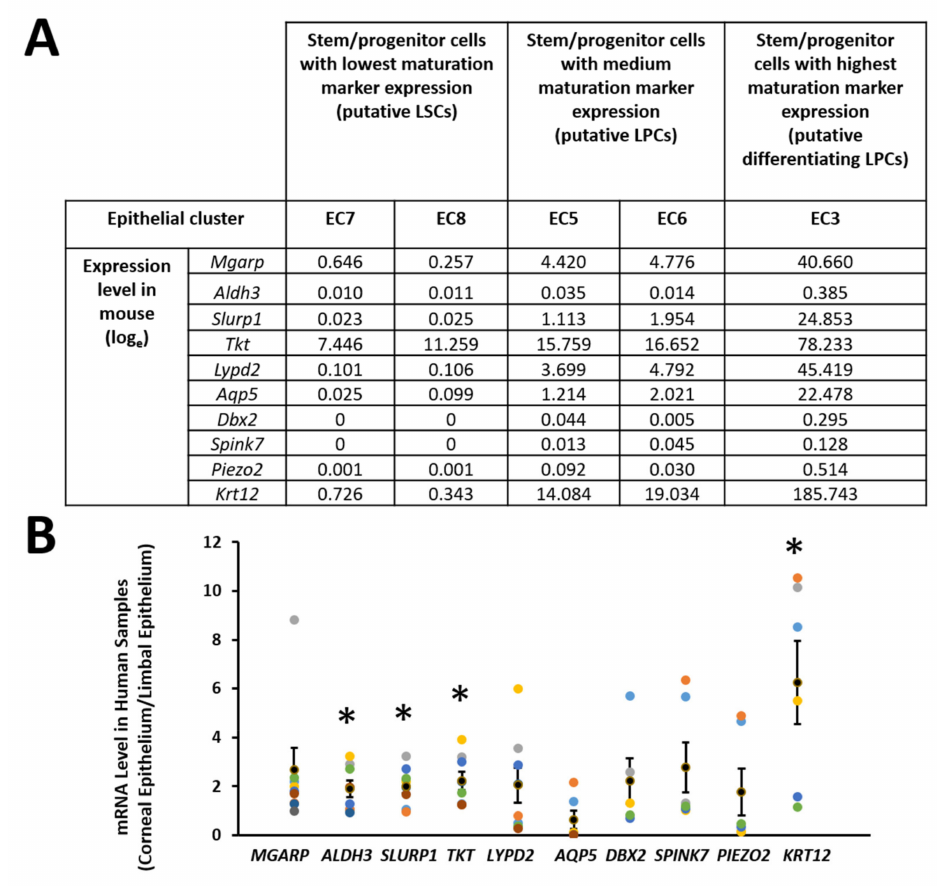
Figure 7. Maturation markers were selected for corneal epithelial differentiation. ( A ) Ten maturation markers were selected based on the increasing expression level along the differentiation trajectory (putative LSCs-putative LPCs-putative differentiating LPCs) revealed by single-cell RNA sequencing. ( B ) Four of the ten markers showed a higher expression in human corneal epithelial cells than those in human limbal epithelial cells revealed by quantitative real-time PCR. The Y-axis represents the fold changes which were calculated as gene expression in corneal epithelial cells/gene expression in limbal epithelial cells from human donors. *: p < 0.05. Dots with different colors indicate the samples from different